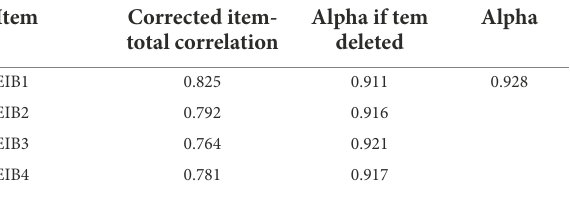
TABLE 3 Analysis and reliability test of individual innovative